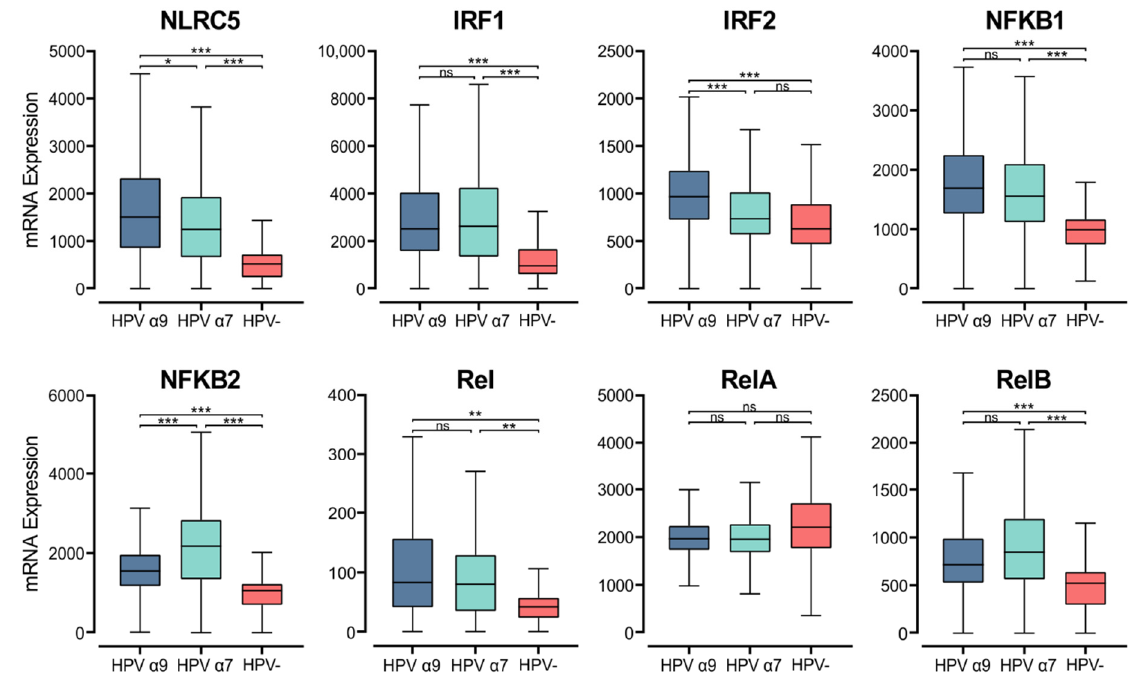
Figure 7. Expression of transcriptional regulators involved in MHC class I expression in CC stratified by HPV+ ( α 9 or α 7) and HPV − status. Normalized RNA-seq data for key transcriptional regulators of MHC class I expression as well as genes in the NF- κ B transcription factor family were extracted from the CC cohort of the TCGA database. *** p ≤ 0.001, ** p ≤ 0.01, * p ≤ 0.05, ns (not significant).